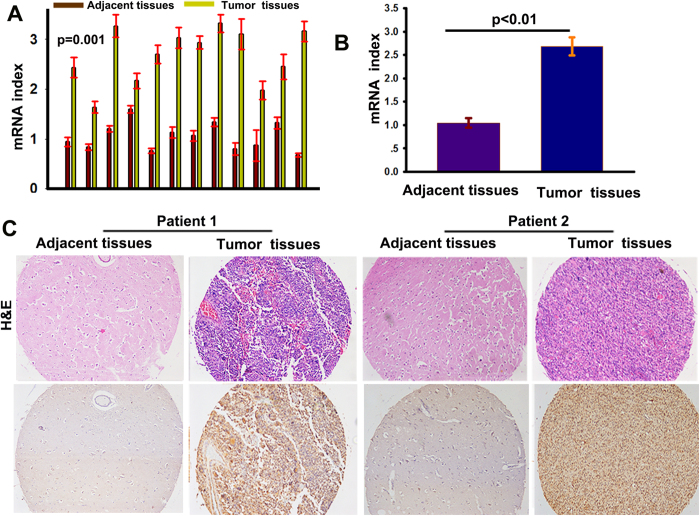
UBE3C overexpresses in gliomas tissues (A and B)The expression of UBE3C mRNA in gliomas samples and the adjacent nontumorous samples; (p < 0.01); (C) Hematoxylin-eosin staining and immunostaining of UBE3C in tumor and the adjacent nontumorous samples (bar = 50 μm).